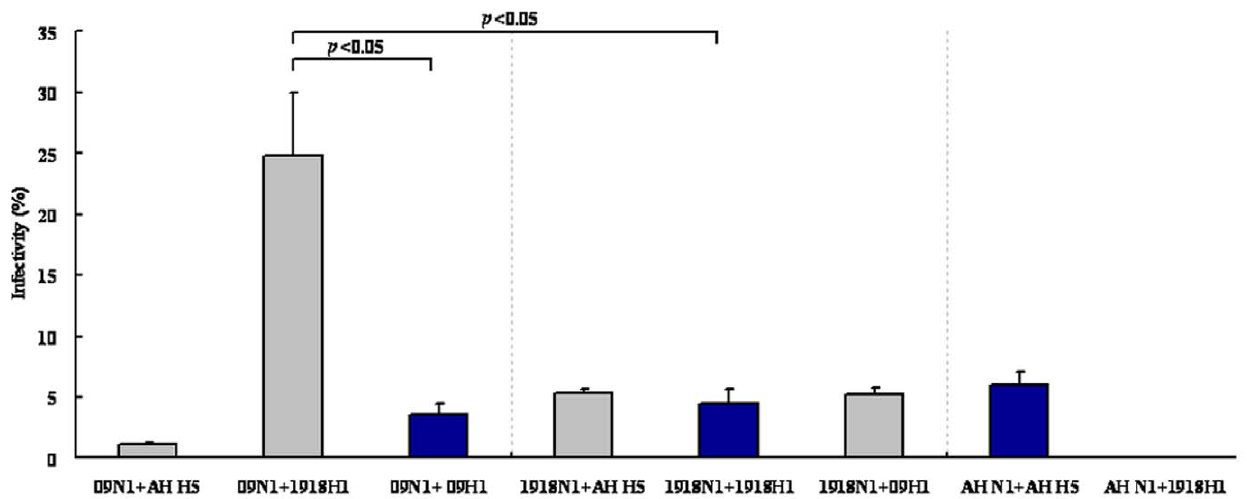
Figure 1. Infectivity assay of all combinations. Infectivity of normalized pps with various HA/NA combinations; infectivity is presented as the Mean 6 SD percentage of infected cells from 3 repeats. All pps were grouped by NA; 2009 H1N1, 1918 H1N1, and H5N1 (A/Anhui/1/2005) are abbreviated as 09, 1918, and AH, respectively.